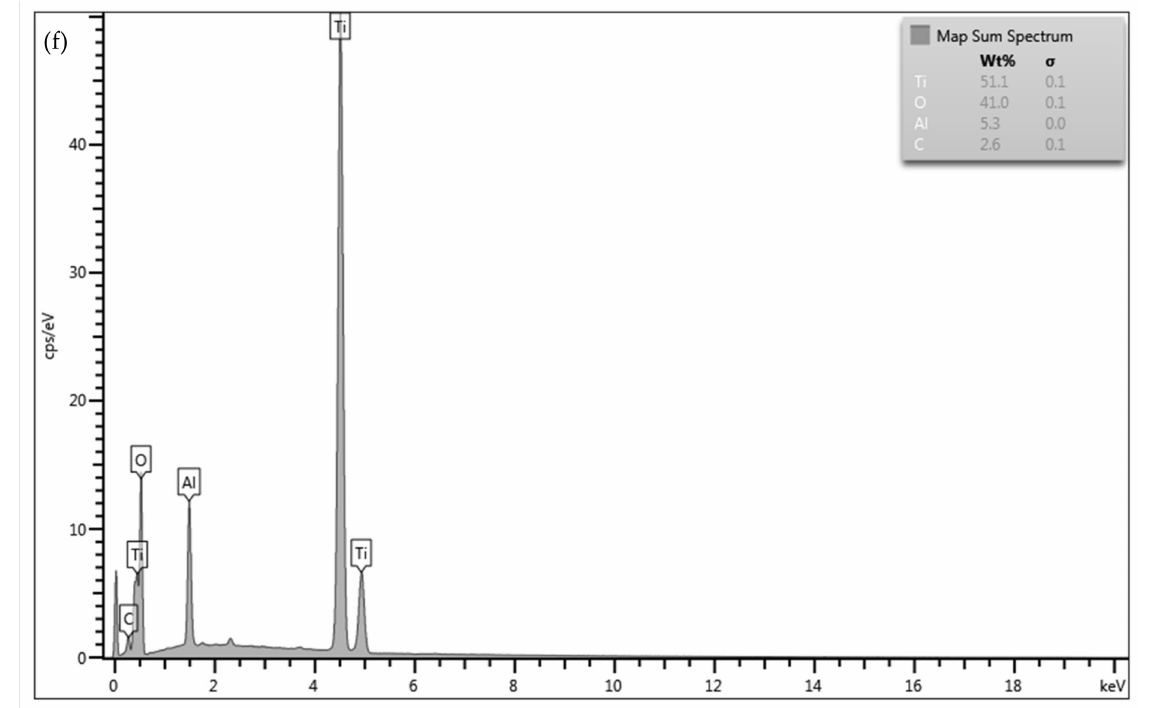
Figure 5. EDX elemental mappings of TiO 2 /annealed AA1050 fracture coating: ( a ) SEM; ( b ) titanium; ( c ) oxygen; ( d ) aluminum; ( e ) carbon; ( f ) map sum